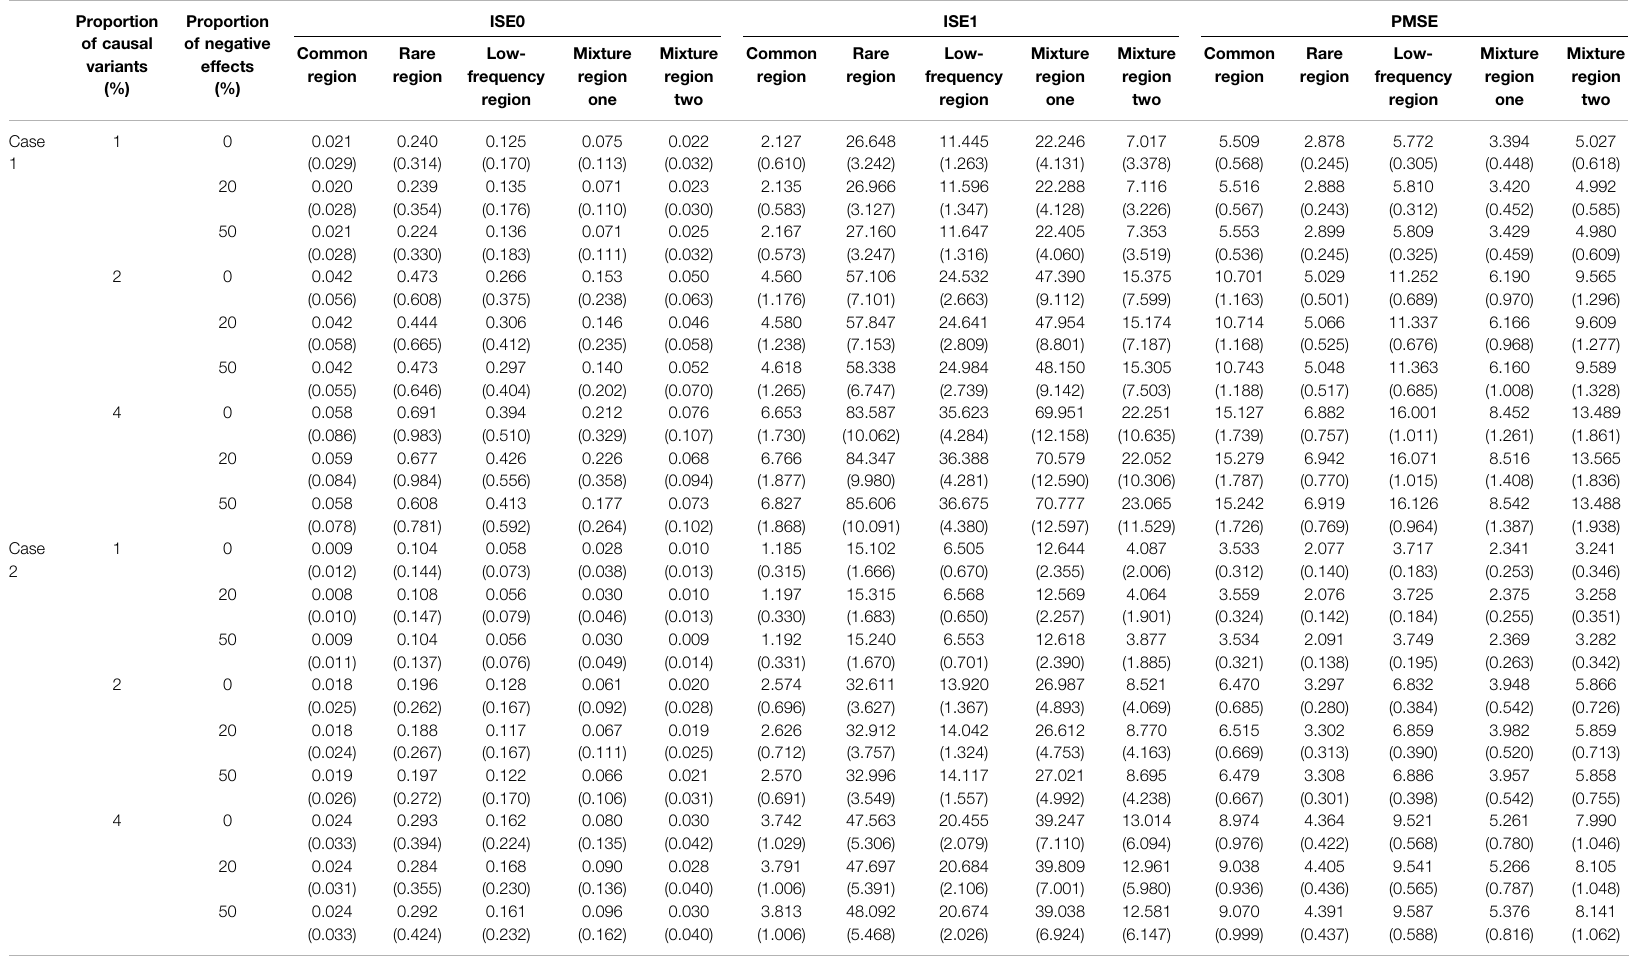
TABLE 3 | The means and standard errors (in the parenthesis) of three indicators based on LFDA for linkage equilibrium simulation when sample size is 2000, c is 3 Proportion of